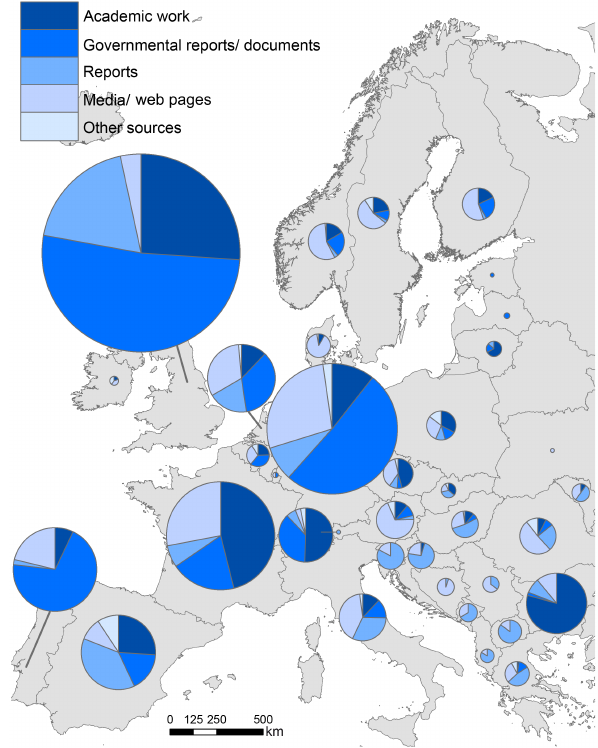
Figure 2. EDII contents by country, with the number of drought im- pact reports (pie size) and the distribution of underlying information sources (legend details as Fig.